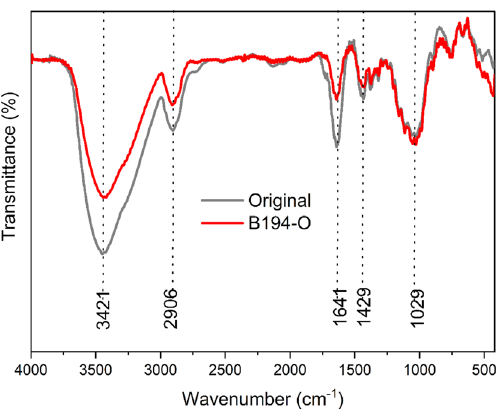
Figure 8. FTIR spectra of original and optimized conditions dyed samples by B194.